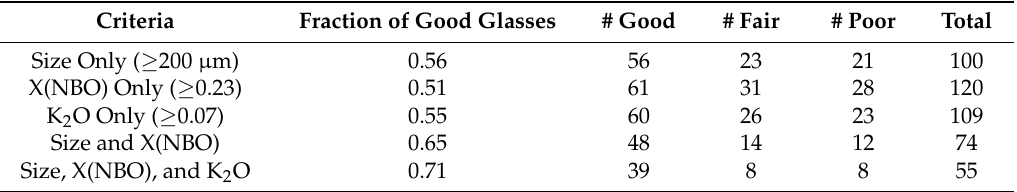
Table 2. Comparison of how applying various selection criteria to lunar impact glasses can affect the likelihood of analyzing glasses that will yield 40 Ar/ 39 Ar ages of ‘good’ quality. Data used from [6–10] and Table 1.